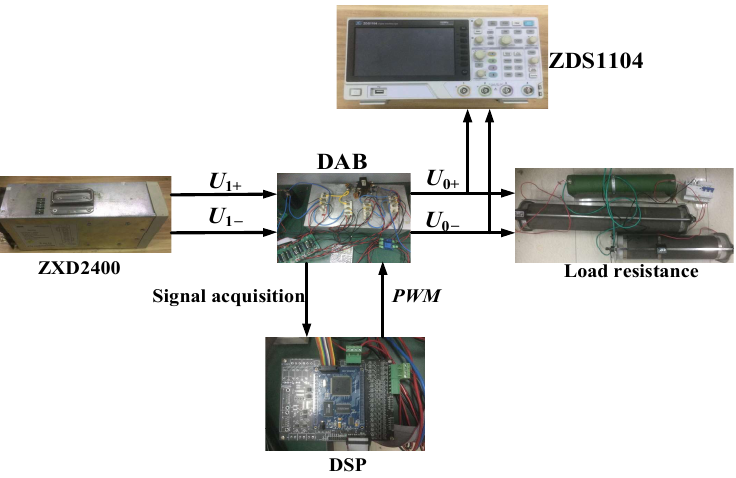
Figure 16. Output voltage of the converter under different control strategies .